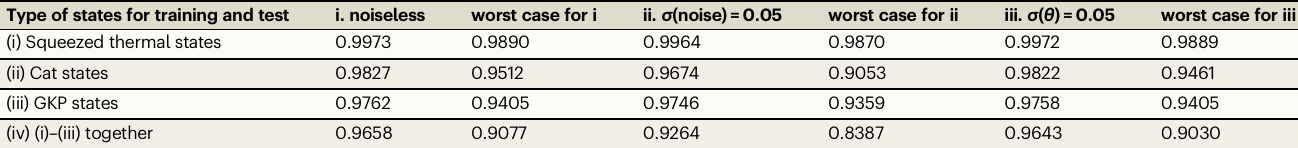
Table 2 | Performances of GQNQ on continuous-variable quantum states Type of states for training and test